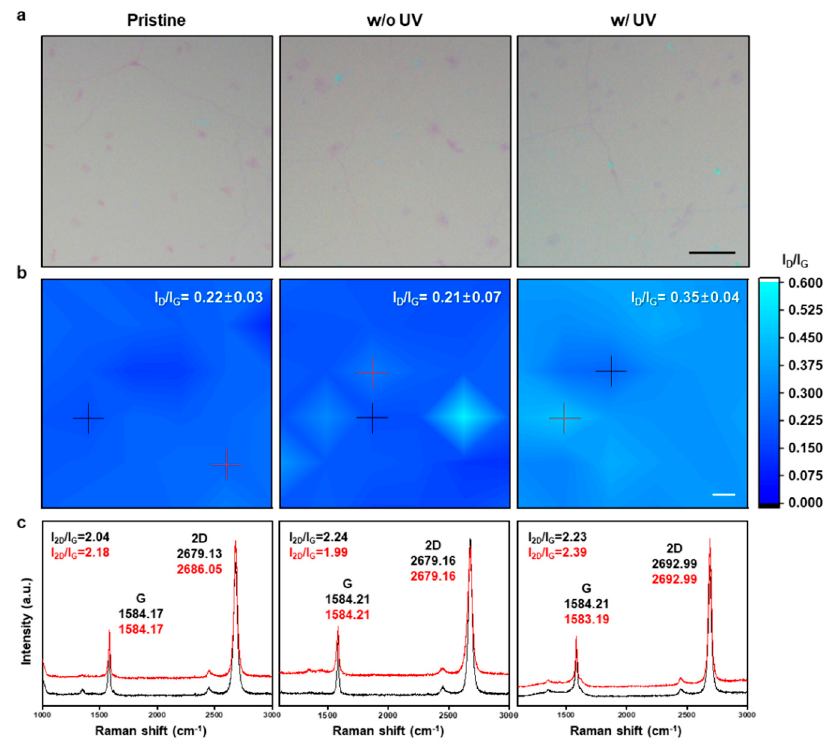
Figure 1. Characterization of graphene before and after usage. ( a ) Representative optical microscopic images of pristine graphene and graphene used for AOP with and without UV treatment. (Magnification ×1k, scale bar 10 μ m) ( b ) Raman mapping of each graphene samples’ I D /I G (Magnification ×500, scale bar 1 μ m), and ( c ) representative Raman spectra.